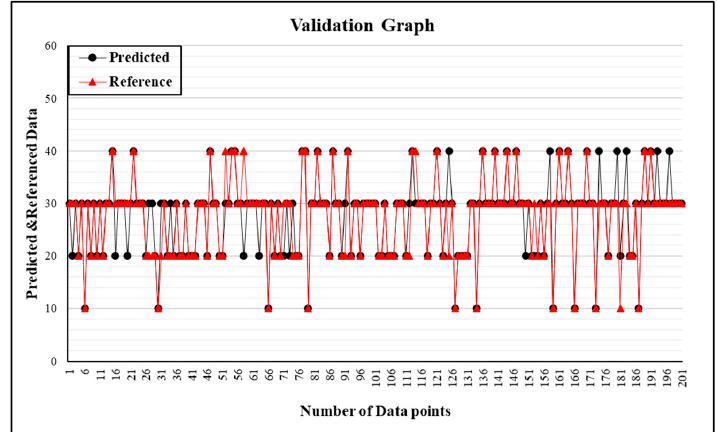
Figure 8. Validation graph of predicted and referenced data points.